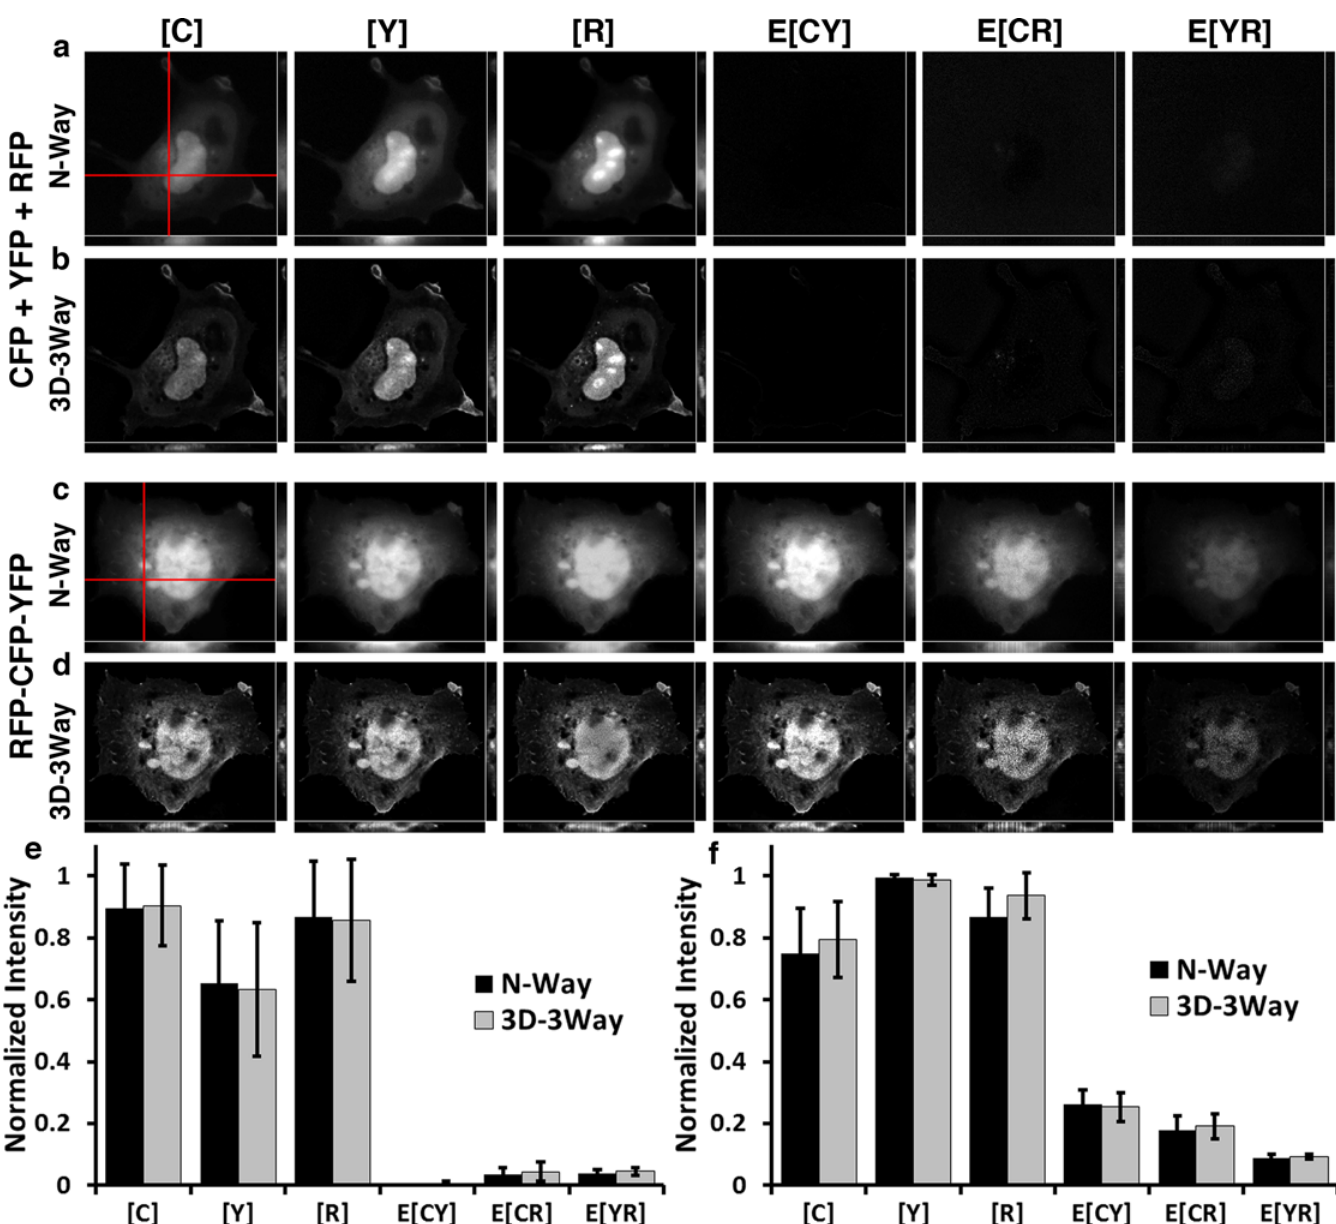
Fig 3. 3D-3Way FRET improved the spatial distributions for free and linked fluorophores without introducing bias. Cos7 cells expressing cytosolic CFP, YFP, and RFP unmixed without deconvolution (a), and improved estimates following 20 iterations of 3D-3Way FRET (b). Cos7 cells expressing triple linked construct RFP-CFP-YFP unmixed without deconvolution (c), and following 20 iterations of 3D-3Way FRET (d). 3D data sets were collected for each cell with a resulting voxel sampling of 133nm X 133nm X 175nm. The images were directly unmixed by N-Way FRET (a and c) and the estimates following 20 iterations of the 3D-3Way FRET algorithm are shown in b and d. The red lines represent the plane taken for xz (shown below panels) and yz projections (shown to right of panels). The total fluorophore concentrations, [X], are co-scaled and E[X] are co-scaled to 30% of the total fluorophore concentrations. The reconstructed images (c and d) have improved resolution, especially the axial resolution as seen in the xz and xy projections. Quantification of fluorescence intensity over the entire 3D volume from CFP, YFP, and RFP (e) or RFP-CFP-YFP (f), unmixed with N-Way FRET (black bars) and also following 3D-3Way FRET (gray bars); error bars are standard deviation, N = 5 cells. 3D-3Way FRET intensities were compared to the corresponding N-Way FRET intensities, and there were no significant differences (p < 0.05) using Two-way ANOVA followed by Tukey HSD post hoc comparison of